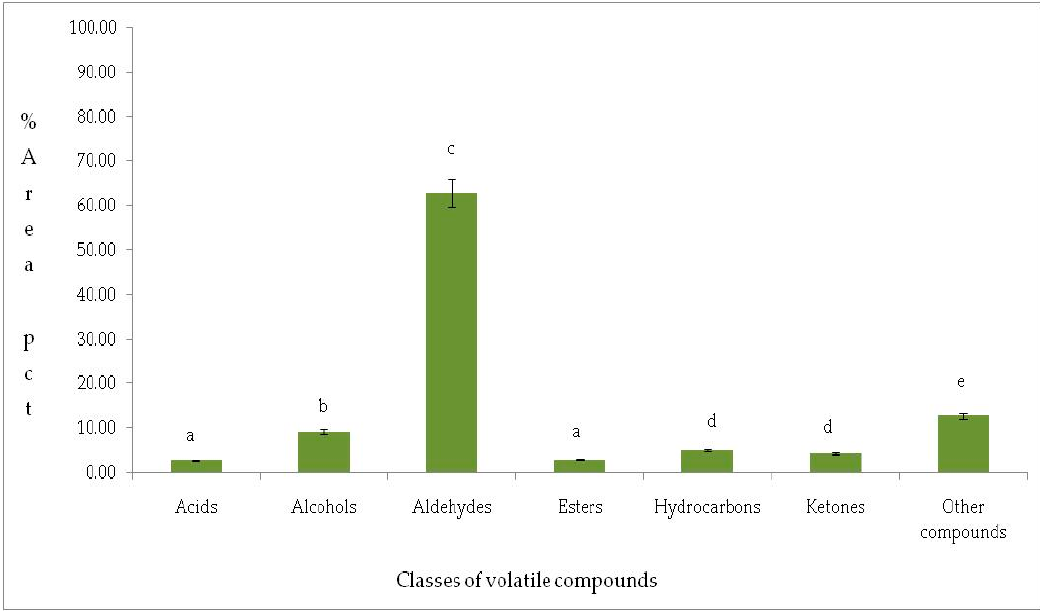
Figure 1. Proportions of classes of volatile compounds identified in prickly pear seed oil (PPSO). Different letters in each bar indicate statistically significant differences ( p <0.05).